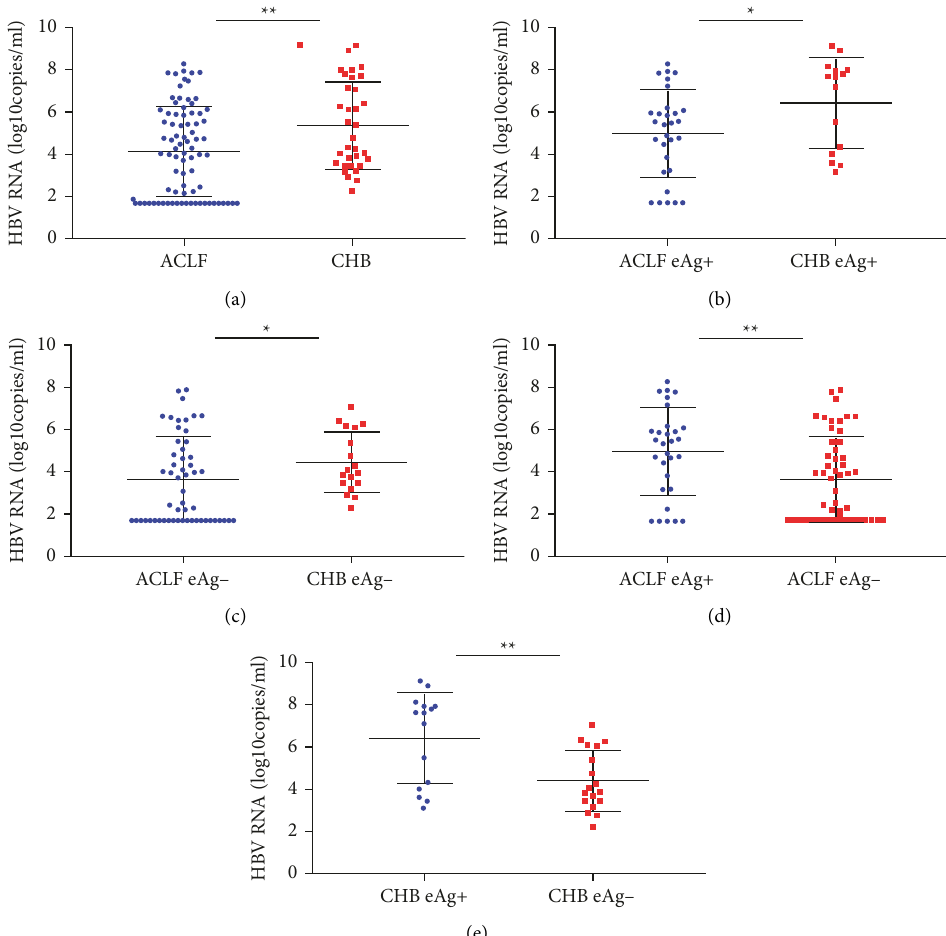
Figure 1: The serum HBV-RNA level in the HBV-ACLF and CHB patients. (a) The mean serum HBV-RNA level (mean ± standard error (SEM)) was significantly lower in the HBV-ACLF patients than in the CHB patients ( P < 0 . 01), in HBeAg-positive patients (b) and HBeAg- negative patients (c). In CHB and HBV-ACLF patients, the serum HBV-RNA levels in the HBeAg-positive patients were higher than that in the HBeAg-negative patients (d and e); ∗ P < 0 . 05 and ∗∗ P < 0 .